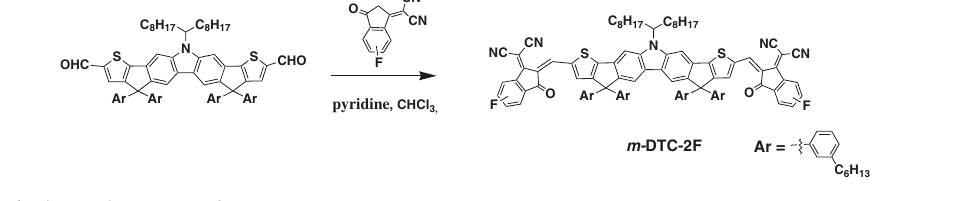
Fig. 3 m -DTC-2F synthesis. Synthetic route of m -DTC-2F.